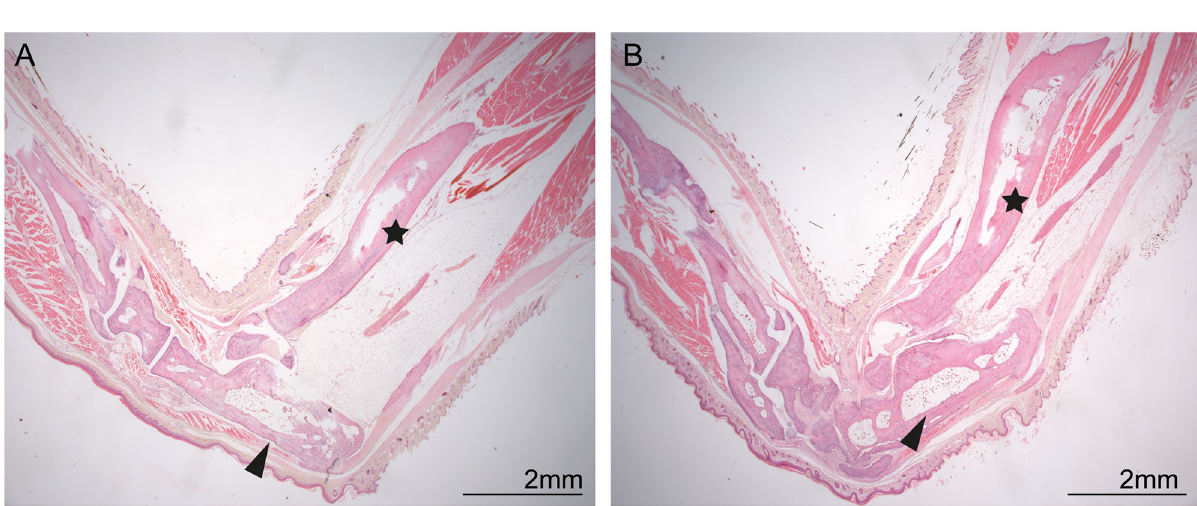
(Table 1). The age of each individual mouse when the injury was first identified is shown in S2 Table. The frequency of affected animals reported represents those animals presenting signs of lameness and/or swelling that could be detected by visual inspection alone. Therefore, the